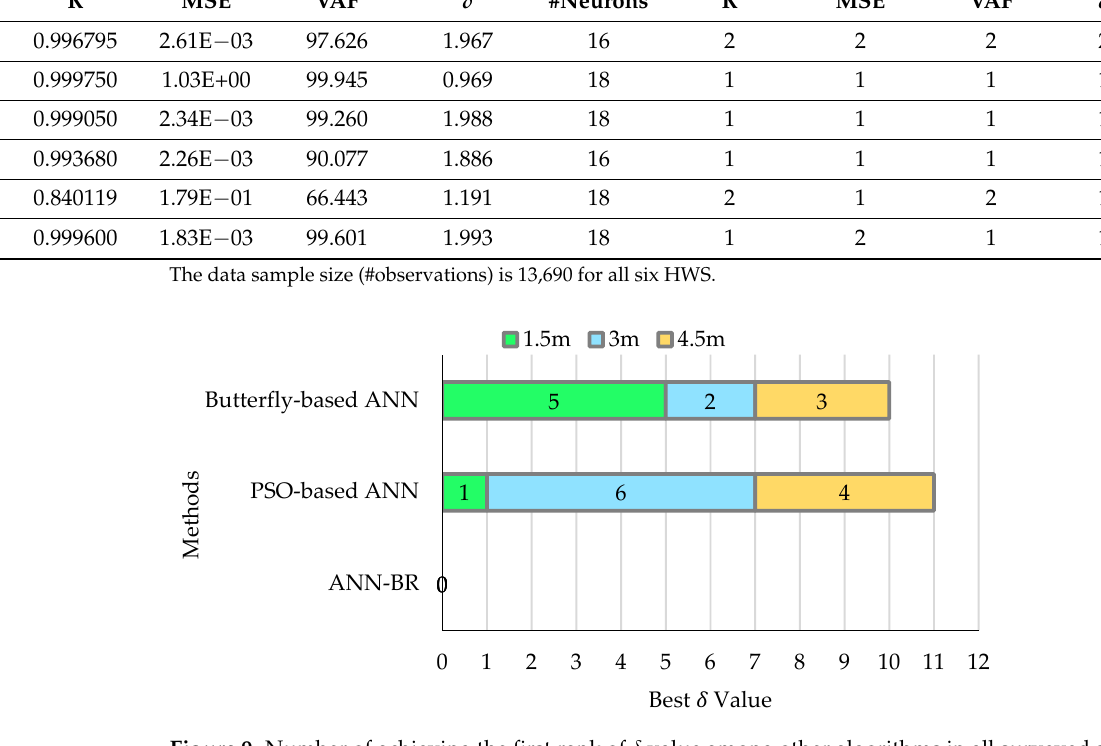
Figure 9. Number of achieving the first rank of δ value among other algorithms in all surveyed spots.